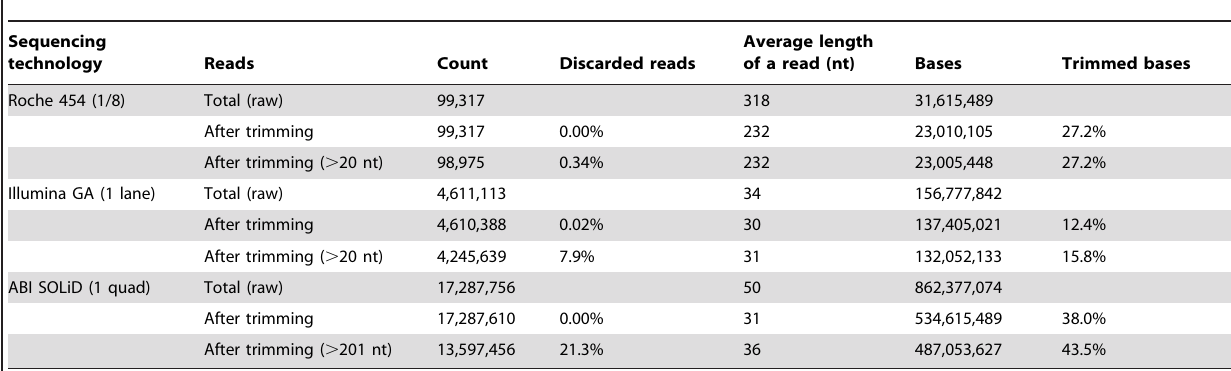
Table 1. Sequence throughput obtained with the three UHTS platforms